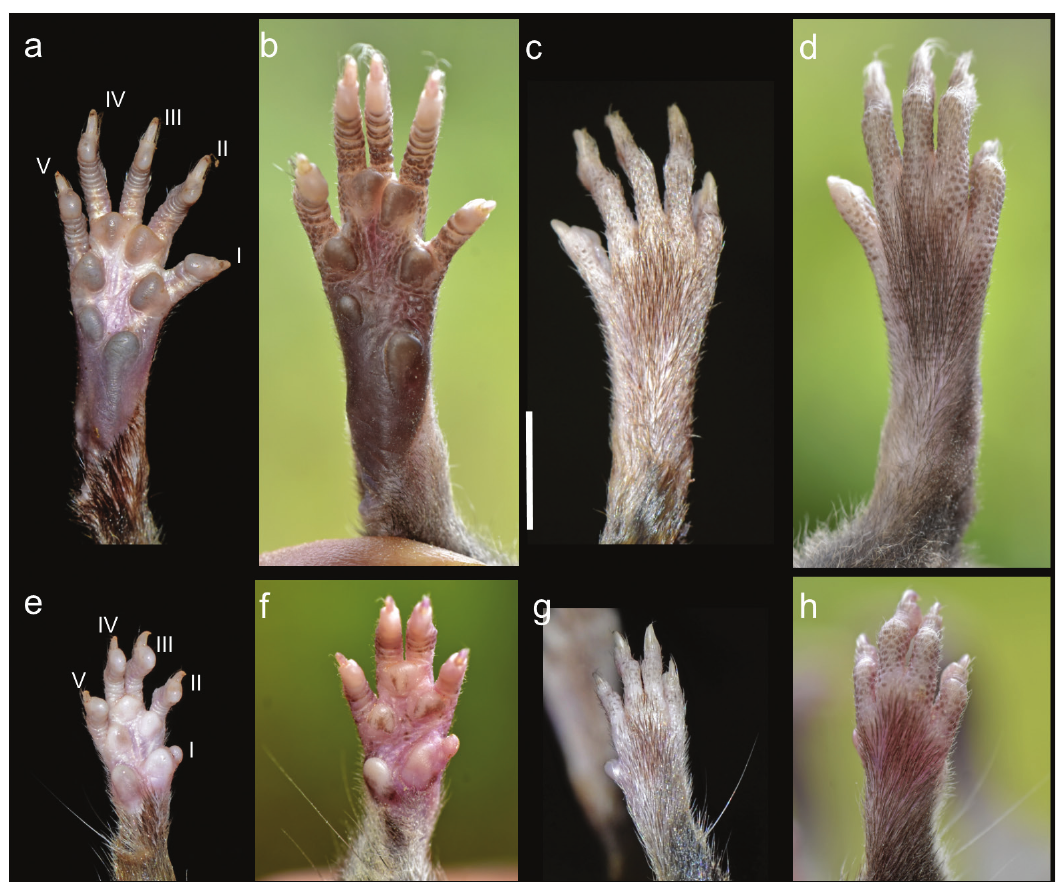
Figure 8. Cheiridia appearance in Mindomys kutuku sp. nov. ( a, c, e, g MECN 5809, holotype; Cordillera de Kutukú, Ecuador), and M. hammondi ( b, d, f, h MECN 6228, Reserva Drácula, Ecuador): Right hind foot, plantar view ( a, b ); Right hind foot, dorsal view ( c, d ); Right fore foot, plantar view ( e, f ); Right fore foot, dorsal view ( g, h ). Scale bar: 10